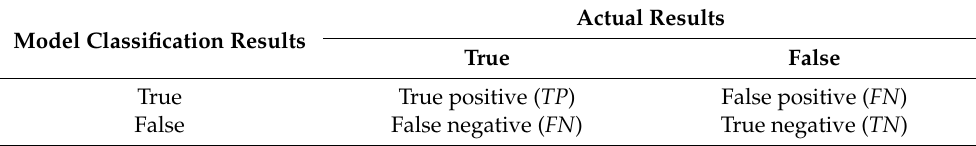
Table 1. Confusion matrix for diagnostic model evaluation. Model Classification